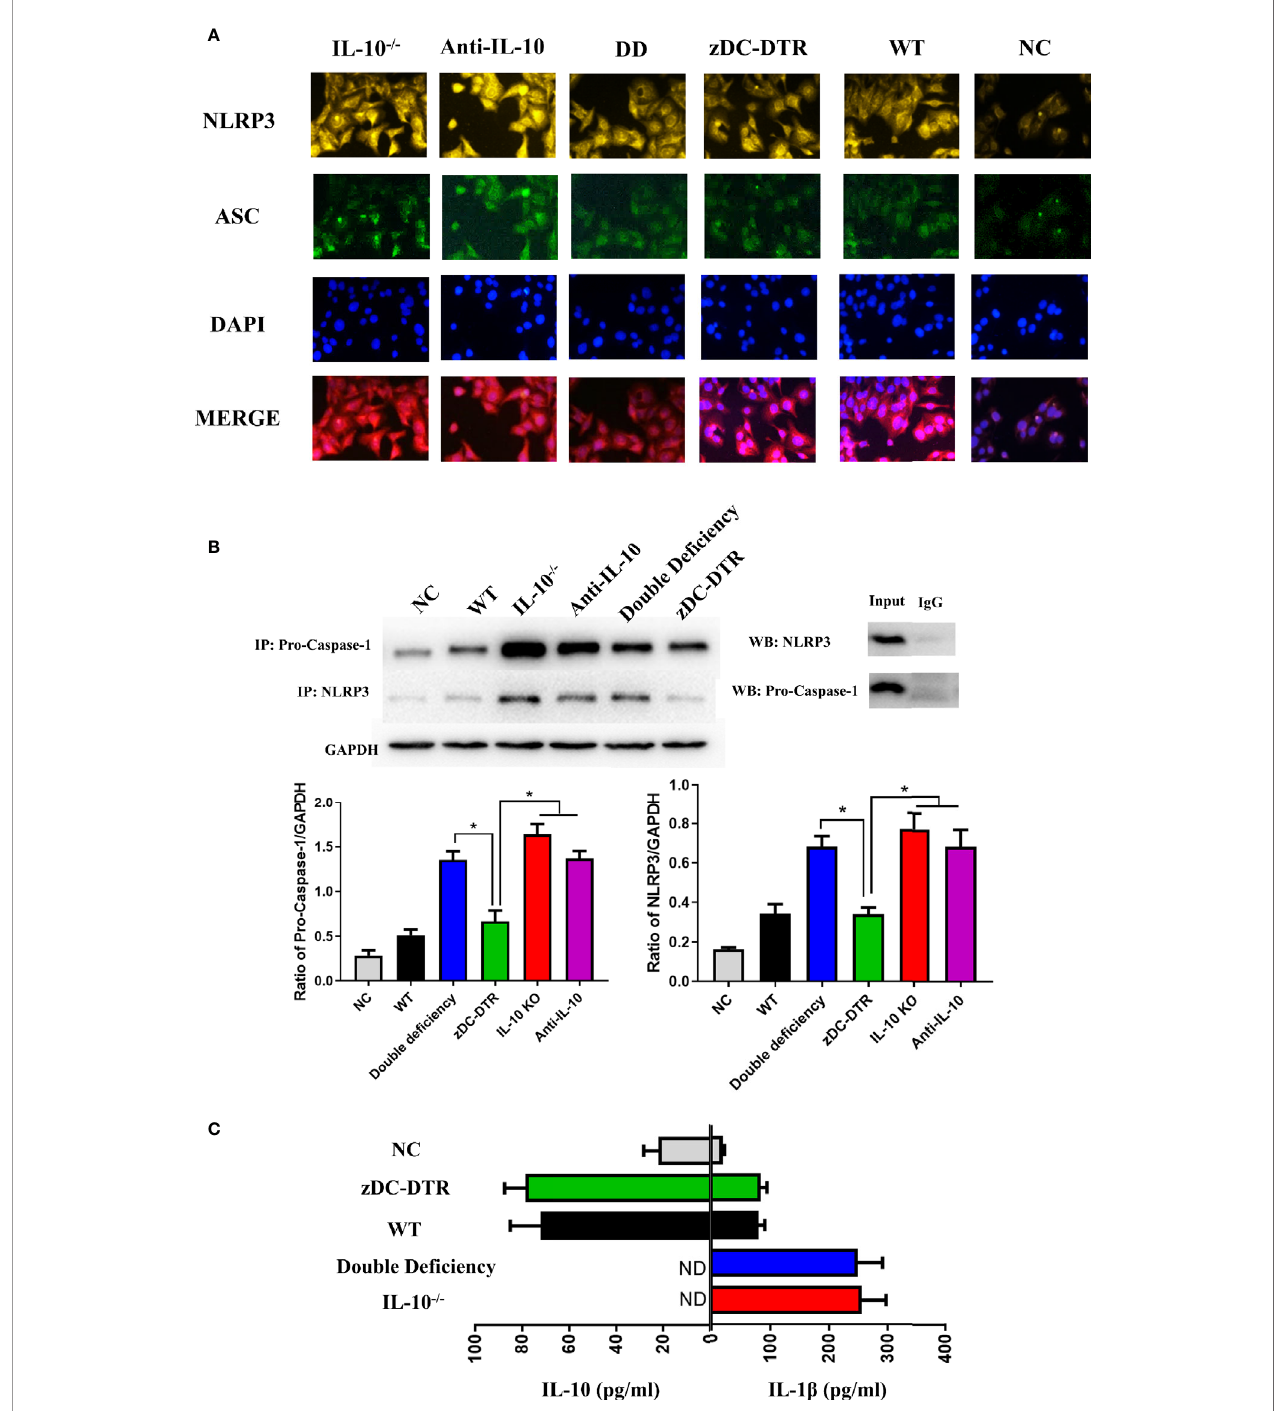
FIGURE 7 | Activation and assembly of the NLRP3 in fl ammasome. (A) BMDCs were fi xed with methanol and incubated with anti-NLRP3 (yellow), anti-ASC (green), and DAPI (blue) at a multiplicity of infection (MOI) of C. psittaci at 72 hpi. The relative fl uorescence intensity was detected co-localization. Co-localization of NLRP3 and ASC was observed more frequently in the IL-10 − / − , anti-IL-10, and DD groups than the zDC-DTR group ( P <0.05). (B) The immunoprecipitation of NLRP3 and pro-caspase 1 was assessed by Western blotting; the ratio of pro-caspase 1 and NLRP3 was calculated to determine the expression levels. Co-immunoprecipitation of NLRP3 and pro- caspase 1 was higher in the IL-10 − / − , the anti-IL-10, and the DD groups than the zDC-DTR group. (C) Secretions of IL-10 and IL-1 b were quanti fi ed in the supernatants of the co-culture system of CD4 + T cells and DCs at 72 hpi using commercial ELISA kits. All data were expressed as the mean ± SD (n=5 per group). The differences were analyzed by ANOVA (* P <0.05, ND, no detection). IL-10 secretion was negatively correlated with the levels of IL-1 b in all